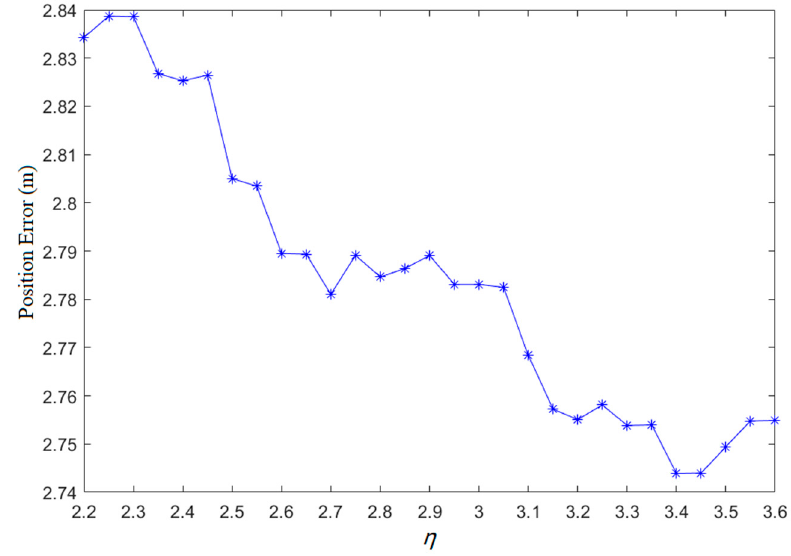
Figure 6. Positioning accuracy with different values of η .